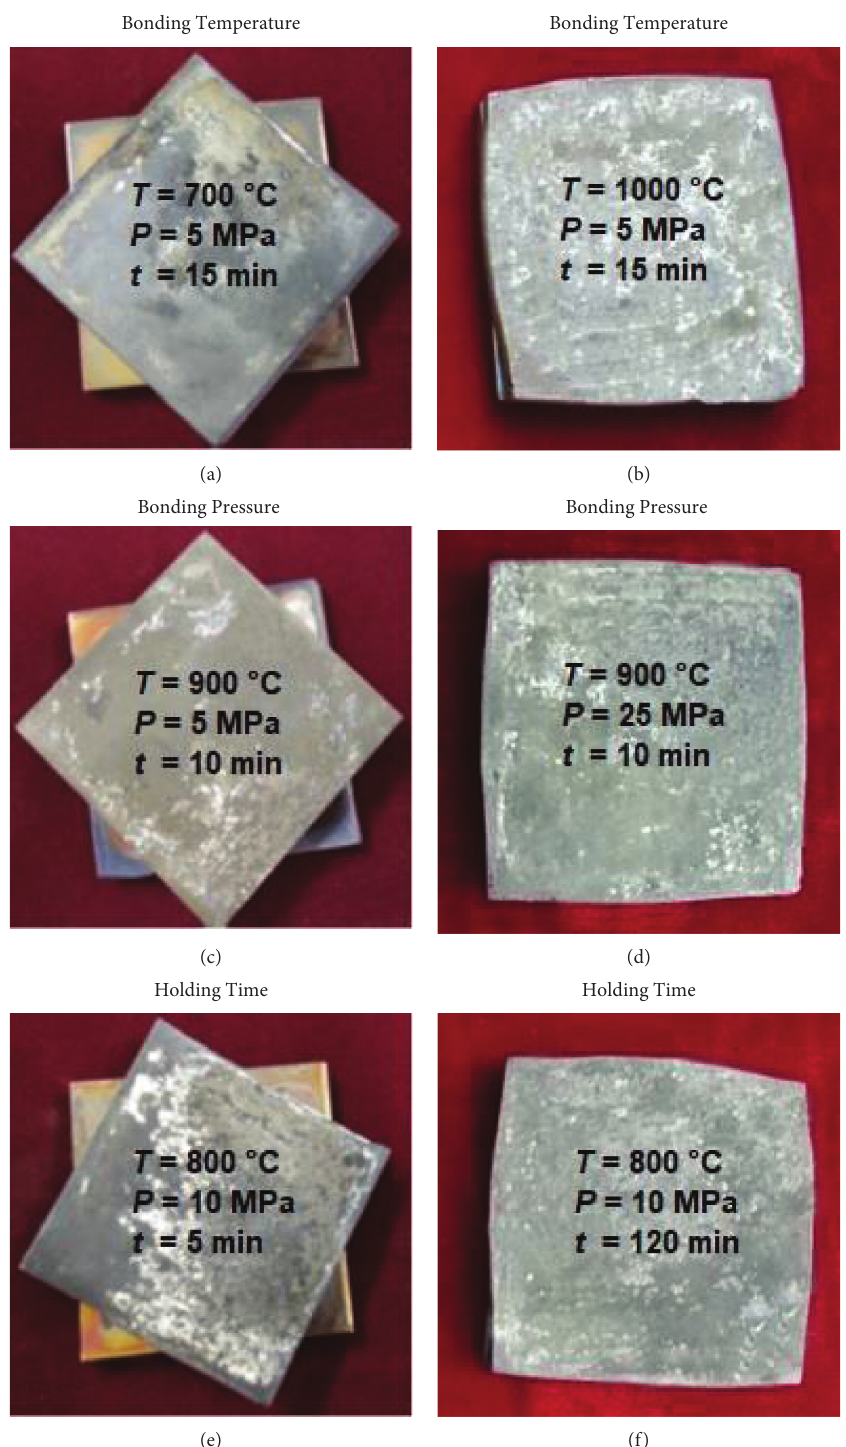
Figure 5: Diffusion bonds fabricated using lower and upper limits of diffusion bonded Ti-6Al-4 V/AISI304 process parameters. (a) Temperature < 750 ° C. (b) Temperature > 950 ° C. (c) Pressure < 10MPa. (d) Pressure > 20MPa. (e) Time < 10min. (f) Time >